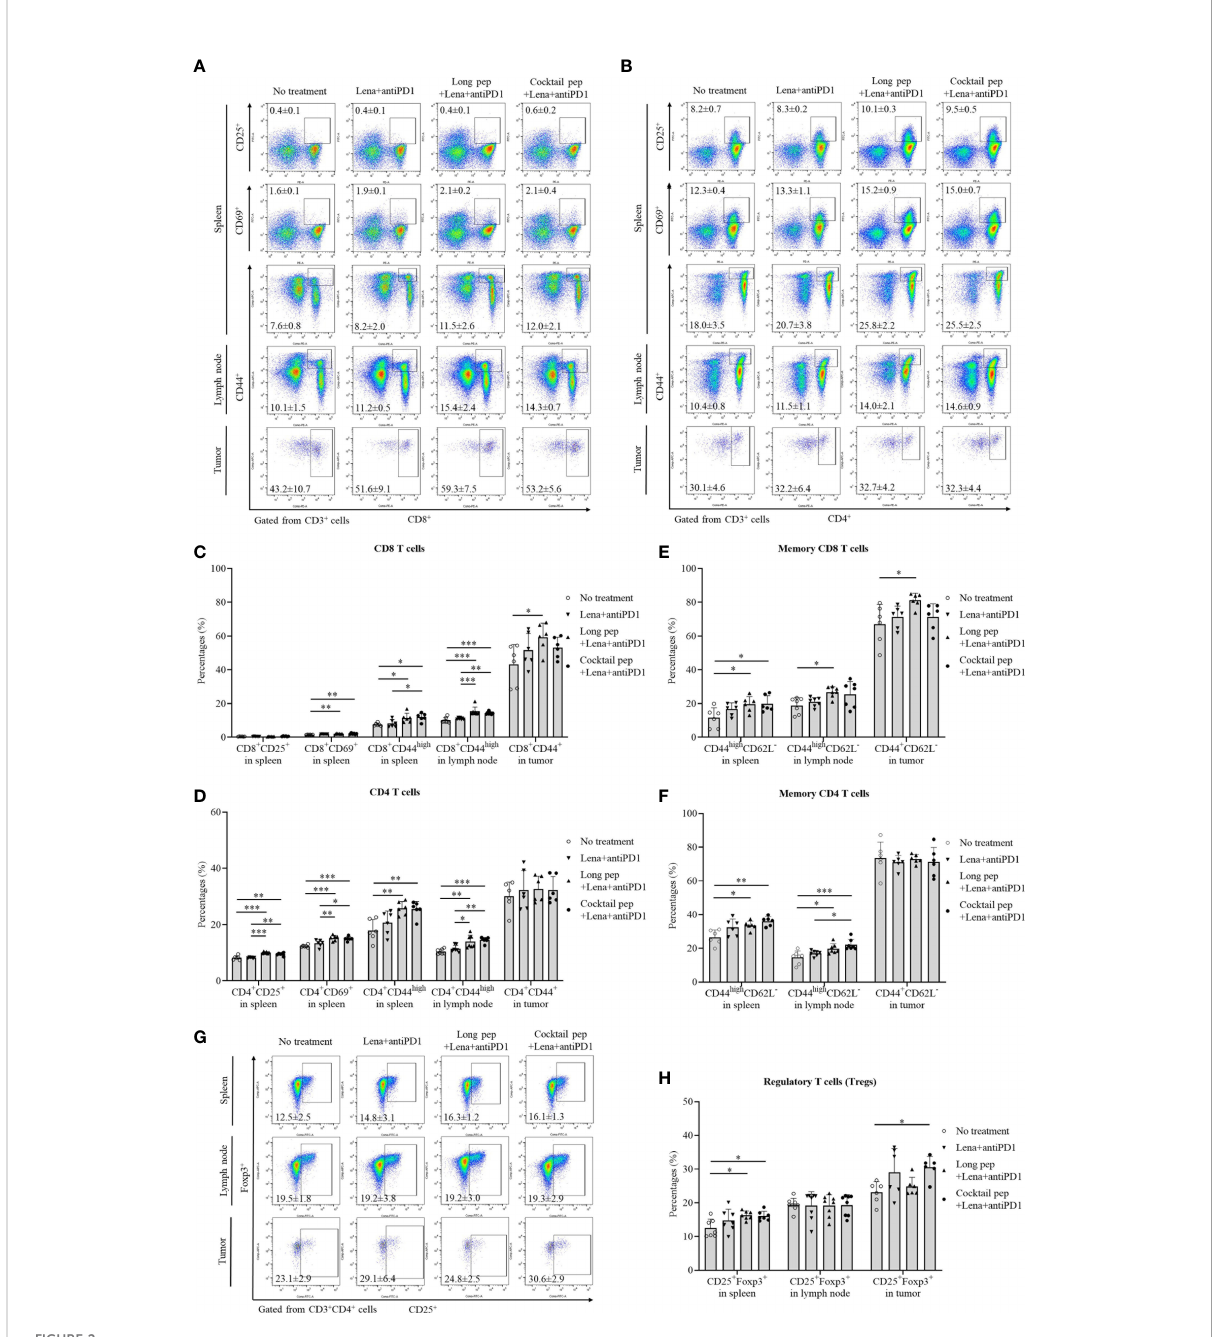
FIGURE 2 The distribution of immune cells in the spleens, lymph nodes, and tumors was con fi rmed by fl ow cytometry. The presentation of activated effector CD8 and CD4 T cells, such as activated CD8 + CD25 + , CD8 + CD69 + , and CD8 + CD44 + or CD4 + CD25 + , CD4 + CD69 + , and CD4 + CD44 + in spleens (n = 6 for each treatment group), lymph nodes (n = 7 for each treatment group), and tumors (n = 6 for each treatment group) were also measured (A-D) . Central memory and effector memory CD8 + and CD4 + T cells in spleens (CD44 high CD62L - and CD44 high CD62L + ) (n = 6 for each treatment group), lymph nodes (CD44 high CD62L - and CD44 high CD62L + ) (n = 7 for each treatment group), and tumors (CD44 + CD62L - and CD44 + CD62L + ) (n = 6 for each treatment group) were also measured (E, F) . The percentages of regulatory T cells (Tregs) (CD4 + CD25 + Foxp3 + ) in spleens (n = 7 for each treatment group), lymph nodes (n = 8 for each treatment group), and tumors (n = 6 for each treatment group) were determined (G, H) . All data is shown as the mean ± standard deviation (SD). No treatment: no treatment group; Long pep: long multi-epitope peptide; Long pep+Lena: long multi-epitope peptide plus lenalidomide; Lena+anti-PD1: Lenalidomide plus anti-PD1; Long pep+Lena+anti-PD1: long multi-epitope peptide plus lenalidomide and anti-PD1; Cocktail pep+Lena+anti-PD1: cocktail of multi-epitope peptide plus lenalidomide and anti-PD1. p< 0.05 (*), p< 0.001 (**), p< 0.0001